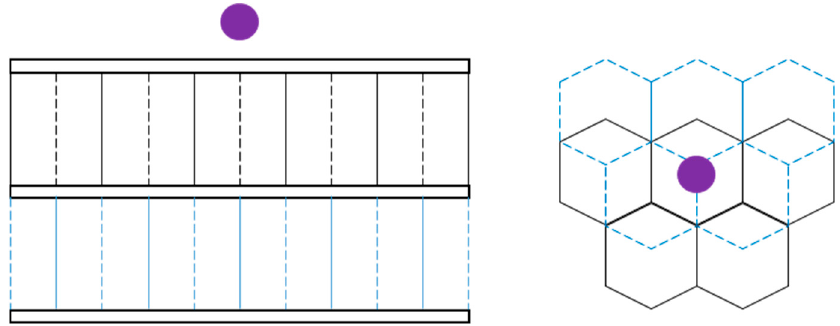
Figure 4. Staggered DHC sandwich panel configuration.